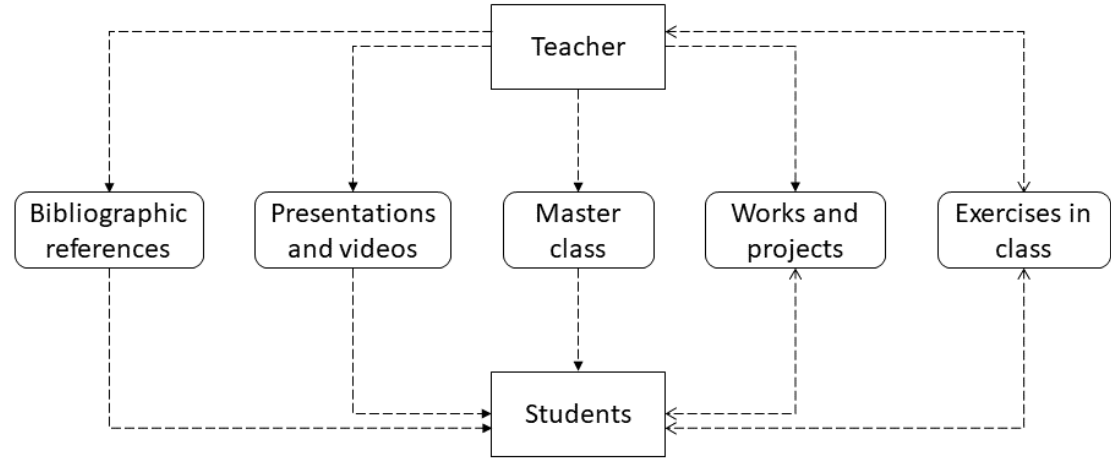
Figure 1. Face-to-face education model, with the teacher as the main actor of learning.